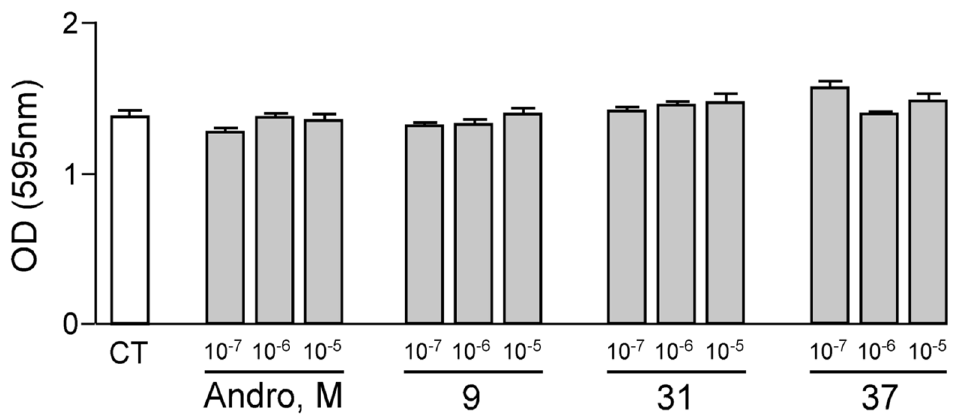
Figure 3. Andrographolide and compounds 9 , 31 , and 37 do not trigger toxicity in SH-SY5Y cells. Cells were incubated without (control, white bar) or with three concentrations (100 nM, 1 µ M, and 10 µ M) of the four compounds for 24 h and cell viability was determined with the MTT assay. The results are expressed as the mean of quadruplicates and no statistical difference were observed.